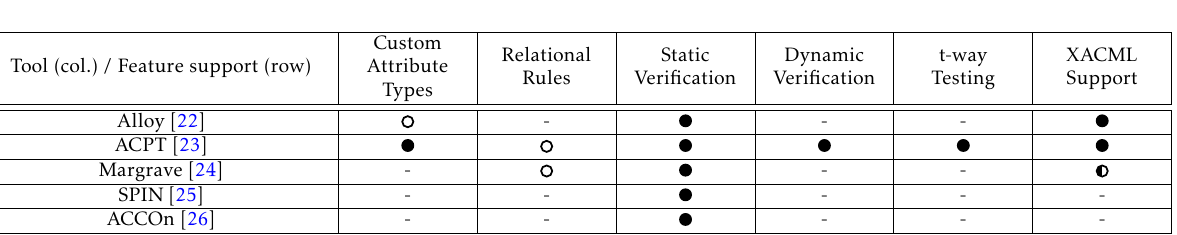
Figure 8. A brief comparison of the model checking tools we considered. A more complete treatment can be found in the work of Aqib and Shaikh